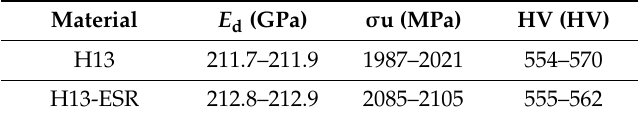
Table 2. Relevant mechanical properties of the two investigated H13 steels.